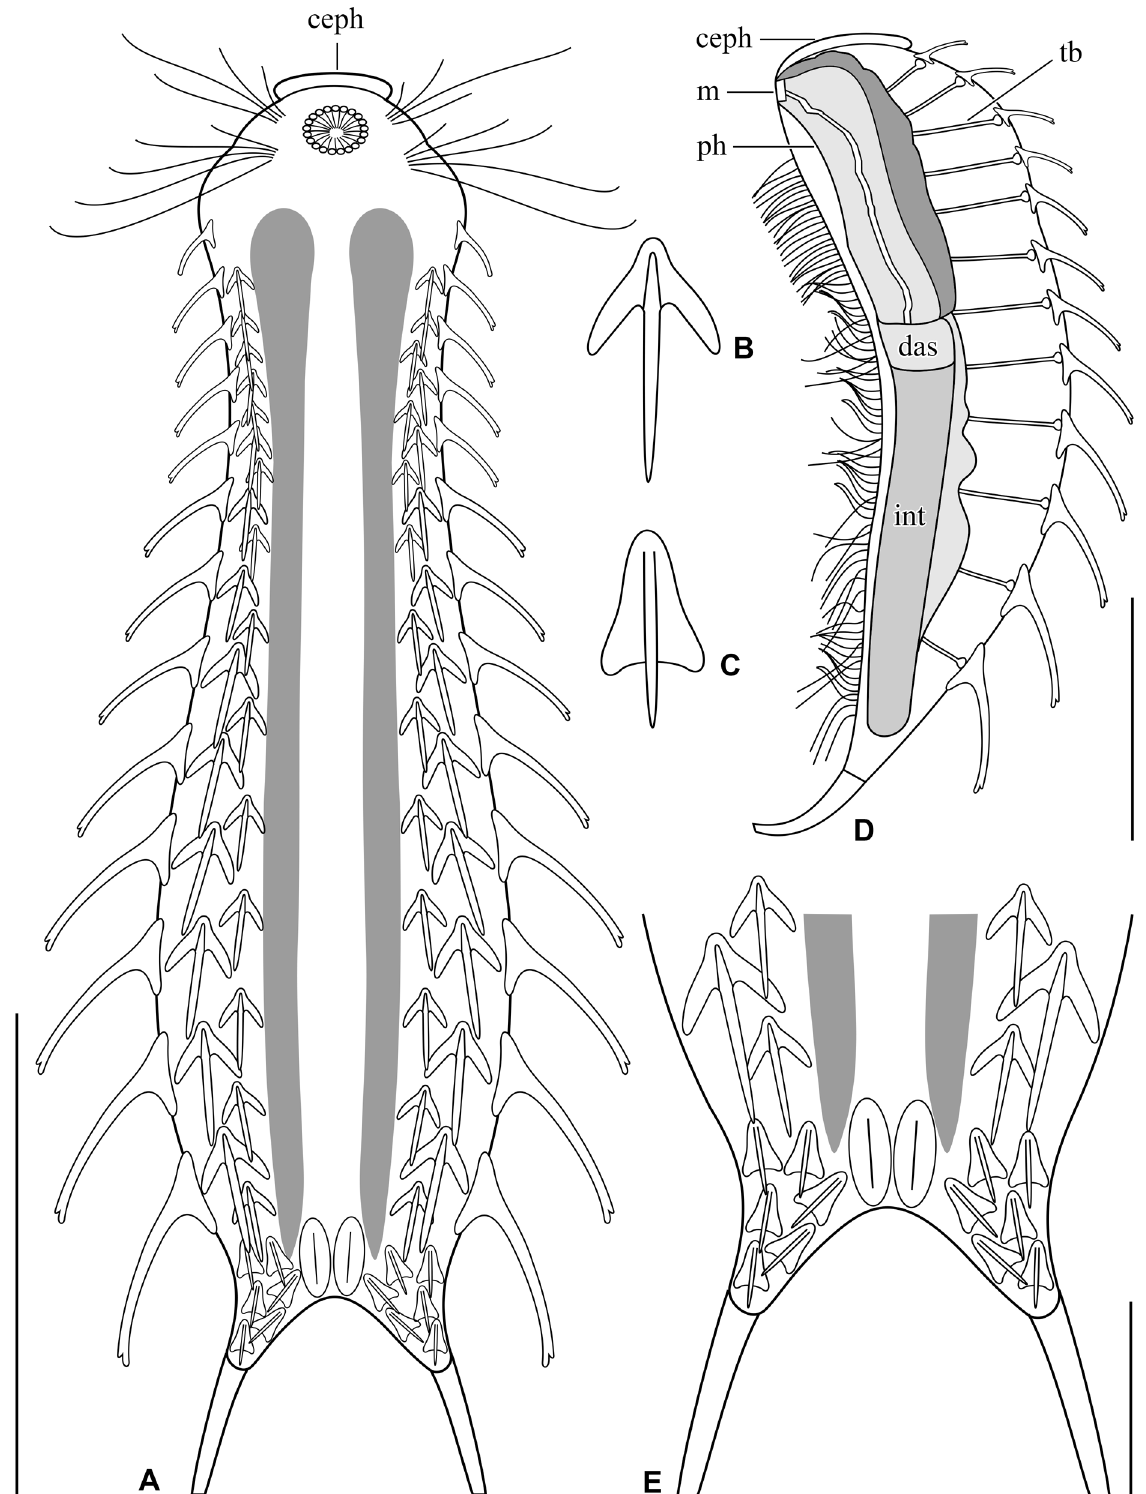
Fig. 29. Chaetonotus ( Hystricochaetonotus ) luxus sp. nov. A . Ventral overview showing the scale and ciliary pattern. B . Ventrolateral scale. C . Ventral furcal scale. D . Internal morphology. E . Detail of the ventral terminal body region. Scale bars: A = 30 µm; D = 20 µm; E = 10